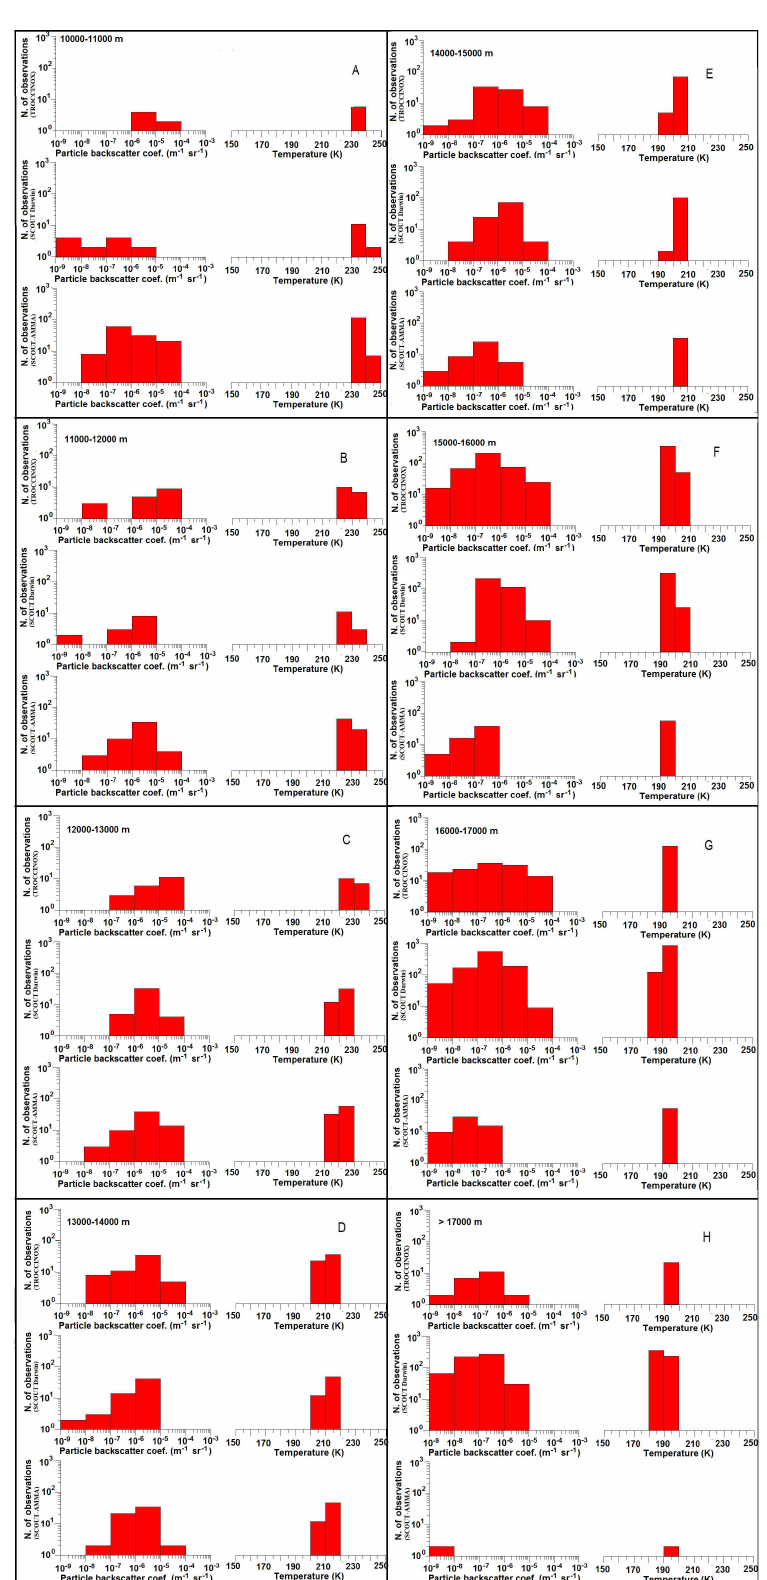
Fig. 1. Panels (A) through (H) show, for altitude ranges from 10000m to 17000m in 1000m steps, the histograms of the measured backscatter coefficients, (left) and temperatures (right). In each panel, the observations have been grouped into different campaigns: SCOUT- AMMA, SCOUT Darwin and TROCCINOX respectively, from bottom to